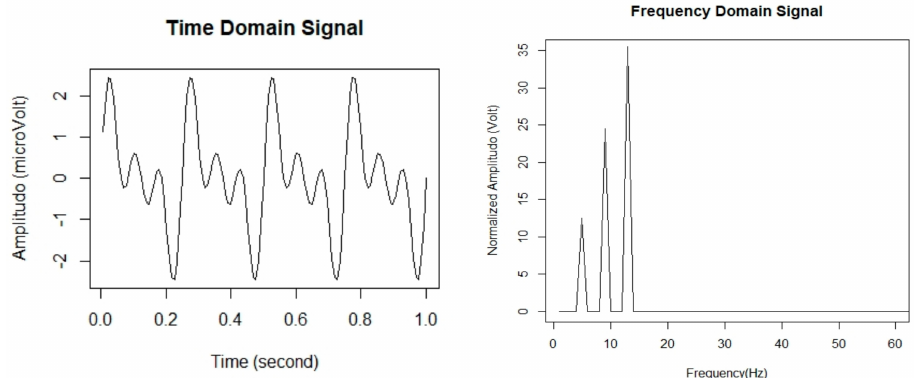
Figure 3. EEG signals in time domain signal and frequency domain